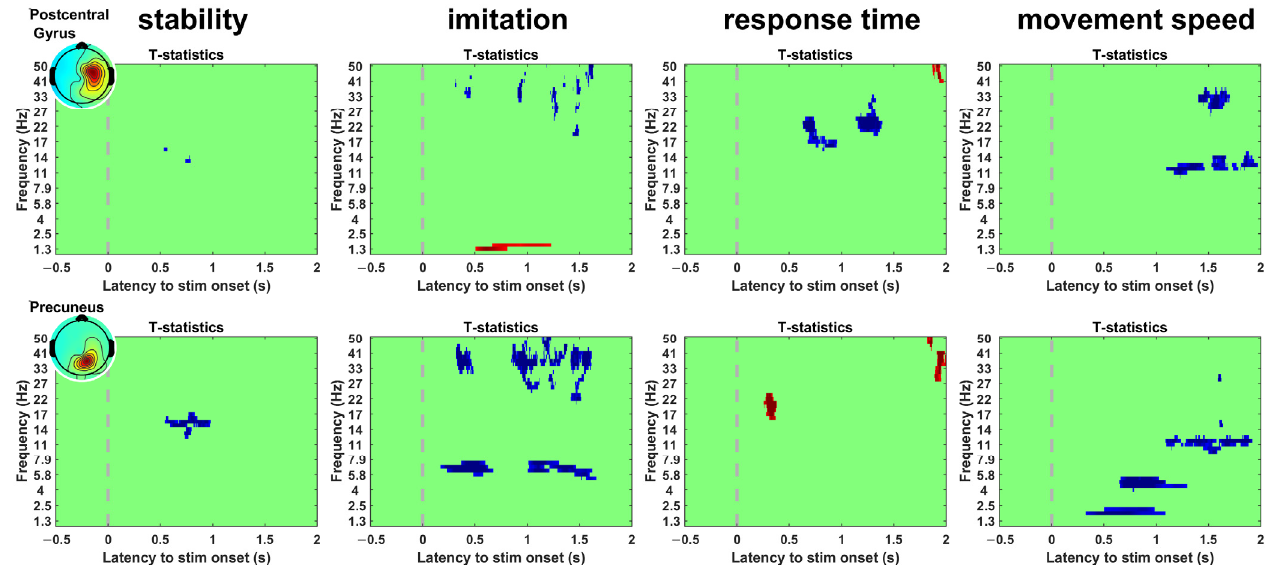
Figure 4. Significant areas in the comparisons; stability (unstable vs. stable), imitation (bad vs. good), response time (delayed vs. no delay), and movement speed (extremely slow vs. extremely fast). The dotted line represents the onset of the “Go” cue. The blue areas represent negative t-statistics, and the red areas represent positive t-statistics.